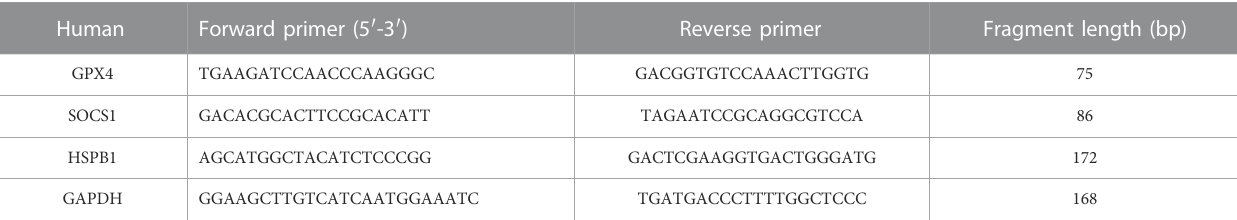
TABLE 1 The primer sets for associated mRNA.